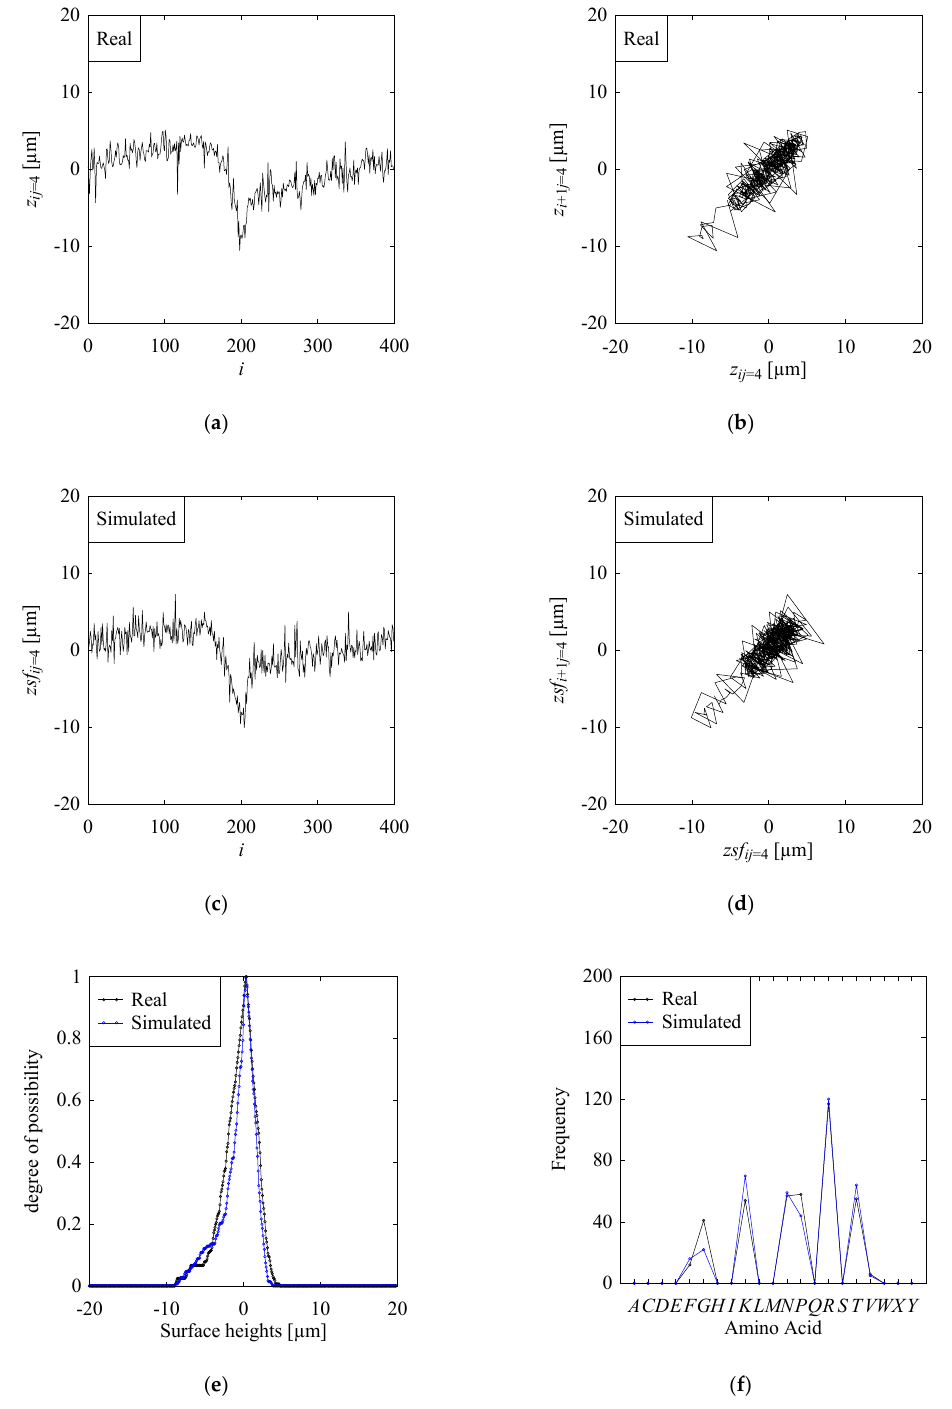
Figure A4. Outcomes of SC and VC corresponding to the semantic modeling-based MC for z ij =4 : ( a ) real surface heights; ( b ) return map of ( a ); ( c ) simulated surface heights; ( d ) return map of ( c ); ( e ) possibility distribution; ( f ) DNA-based computing.